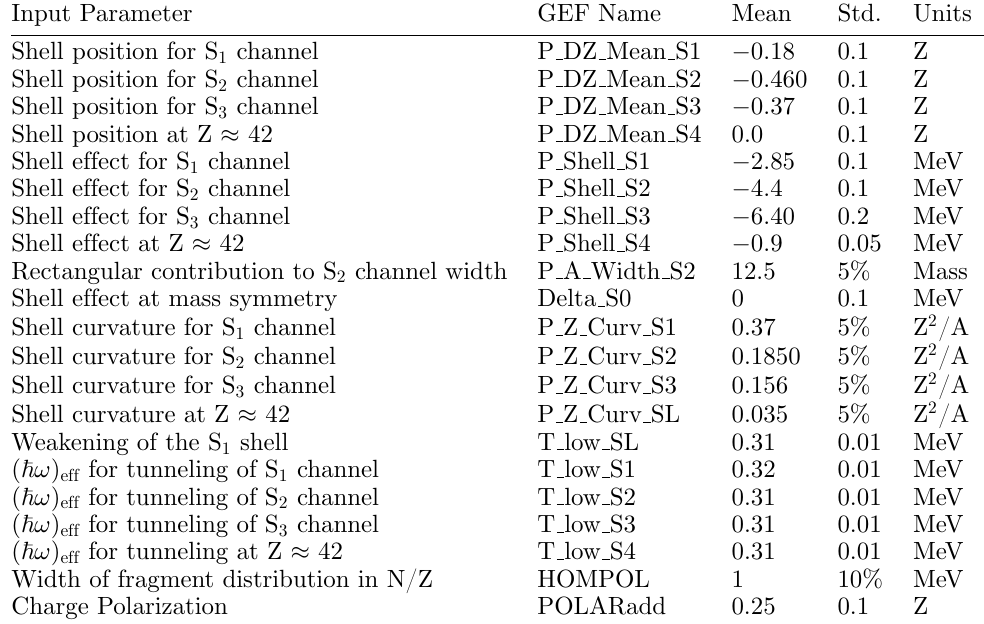
Table 1. Means and standard deviations of GEF model parameters in GEF2017/1.1 [38]. Input